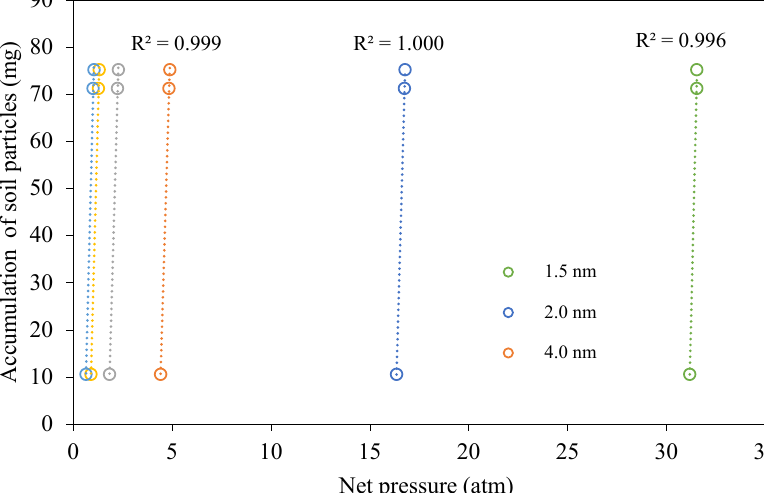
Figure 4. Relationship of net pressure and accumulation of soil particles.